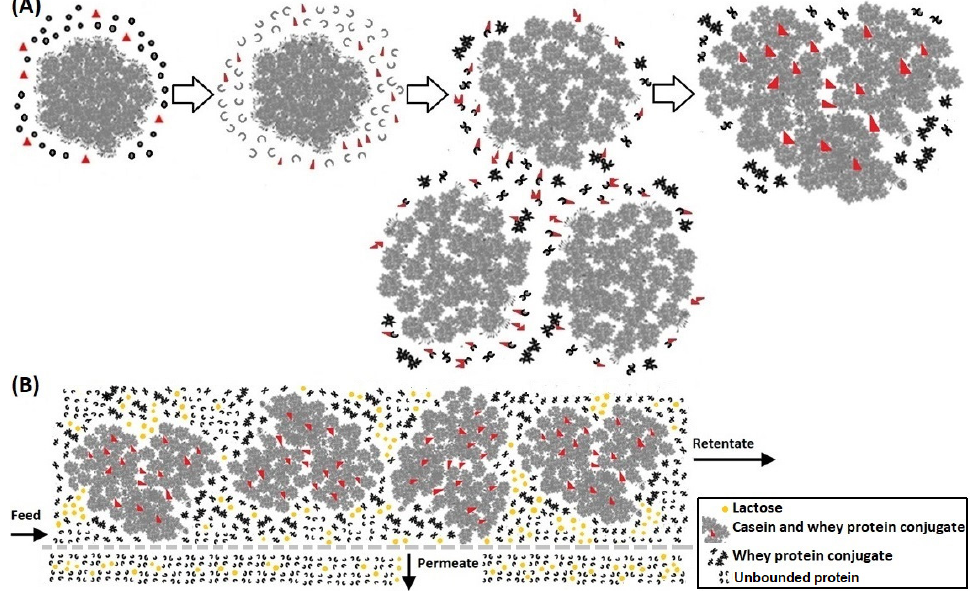
Figure 3. Schematic representation of the conformational modification of proteins during the heat- treatment of skimmed cow’s milk ( A ) (self-developed; the concept was adopted from Vasbinder et al., 2004 [50]); and the production of LMPC from UHT skimmed cow’s milk by membrane filtration ( B ) (graphic self-developed; the concept was adopted from Li et al., 2015 [51]). membrane, and residual (unbounded) whey proteins and lactose have permeated through the membrane pores during filtration (Figure 3B). Due to the addition of milk in a surface was low. As a result, the reduction of permeate flux was low compared to the filtration process, without the addition of milk in an intermediate way.